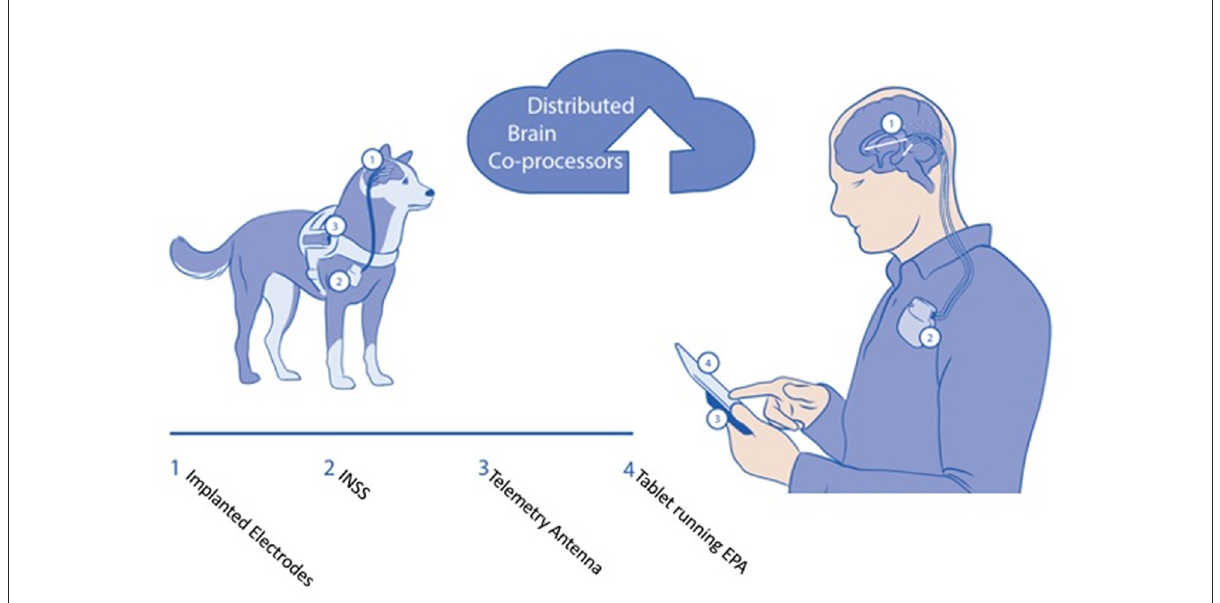
FIGURE3 Schematic of brain co-processor system for canines and human epilepsy. The system consists of: (1) Implanted lead with multiple recording and stimulation contacts (2). Implanted neural sensing and stimulation device. In the canine, the INSS is implanted adjacent to the scapula, and in humans below the clavicle (3). The embodiment of the system using the Medtronic RC + S TM Summit device requires a telemetry antenna (4). The tablet and smartphone can run the epilepsy patient assistant application that integrates the hardware device and provides bi-directional connectivity to the cloud environment. Automated algorithms for detecting seizures and interictal activity run continuously in the cloud and tablet